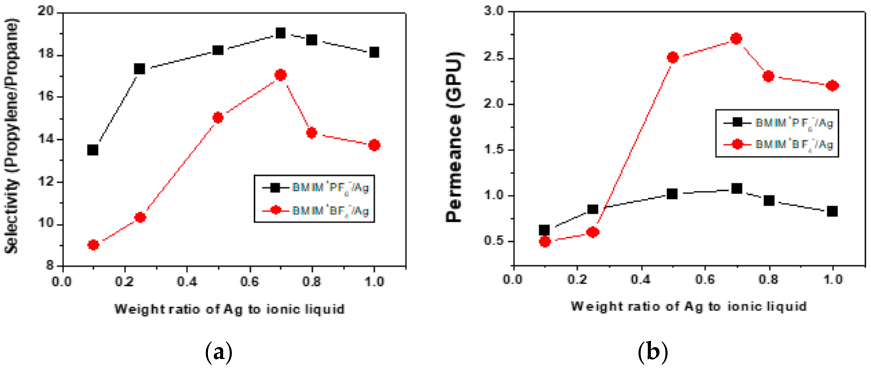
Figure 1. Separation performance: ( a ) mixed gas selectivity and ( b ) total permeance of BMIM + BF 4 − and BMIM + PF 6 − membranes with various weight ratios of silver nanoparticles.